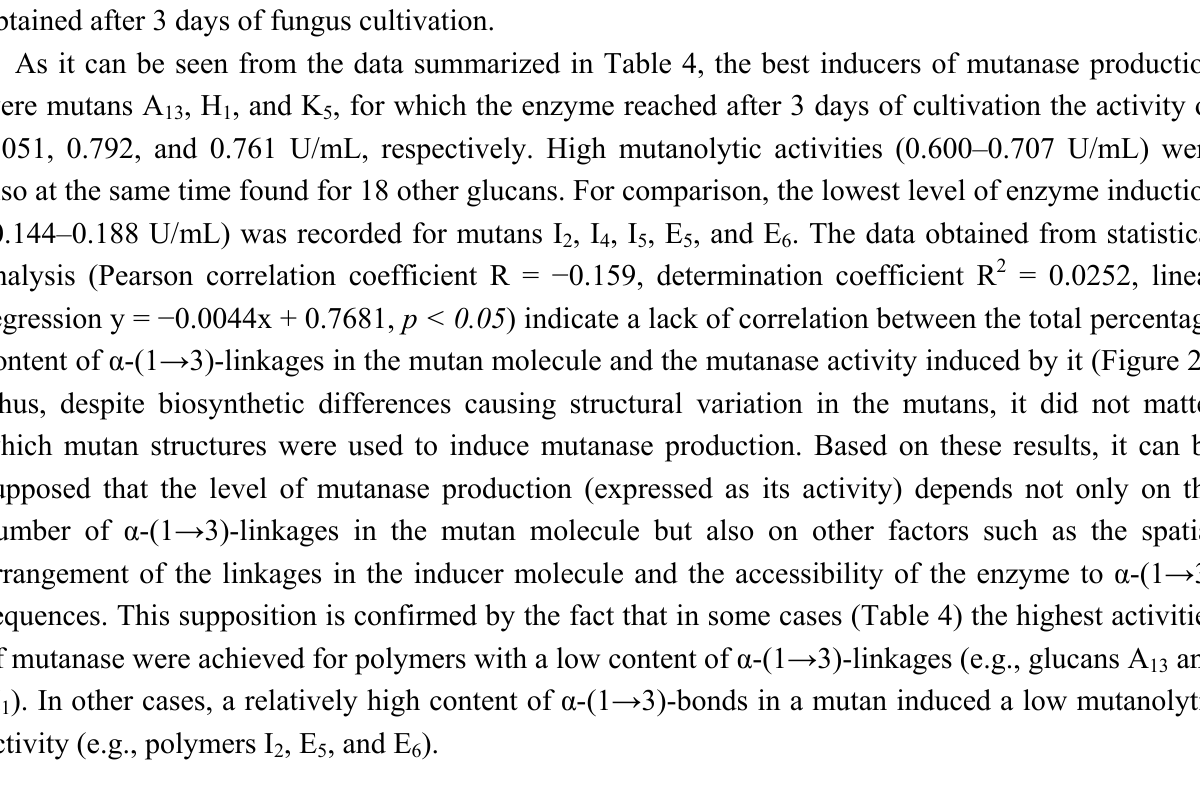
Table 4. Influence of structurally diversified mutans on mutanase production by T. harzianum F-340 in shaken flask